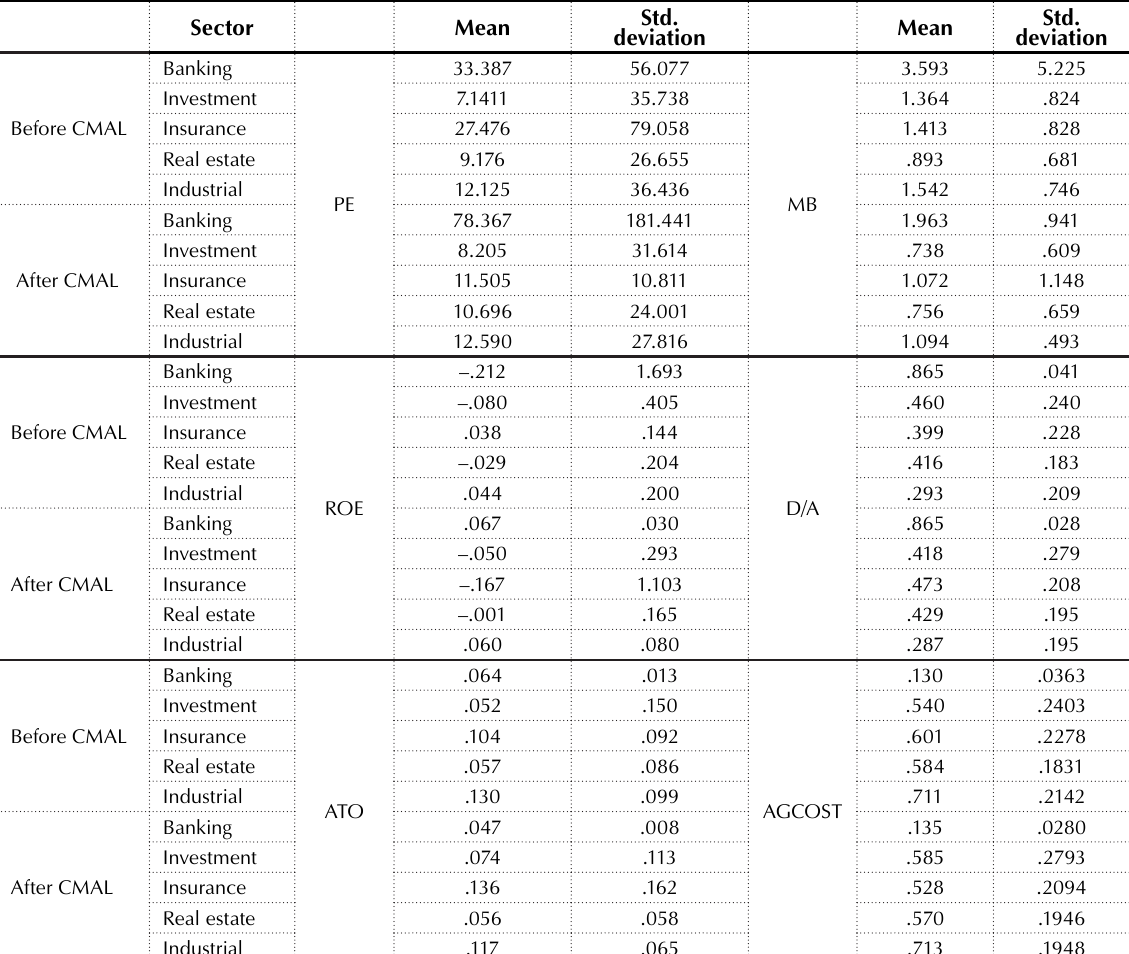
Table 1. Summary results of the mean and standard deviation before and after